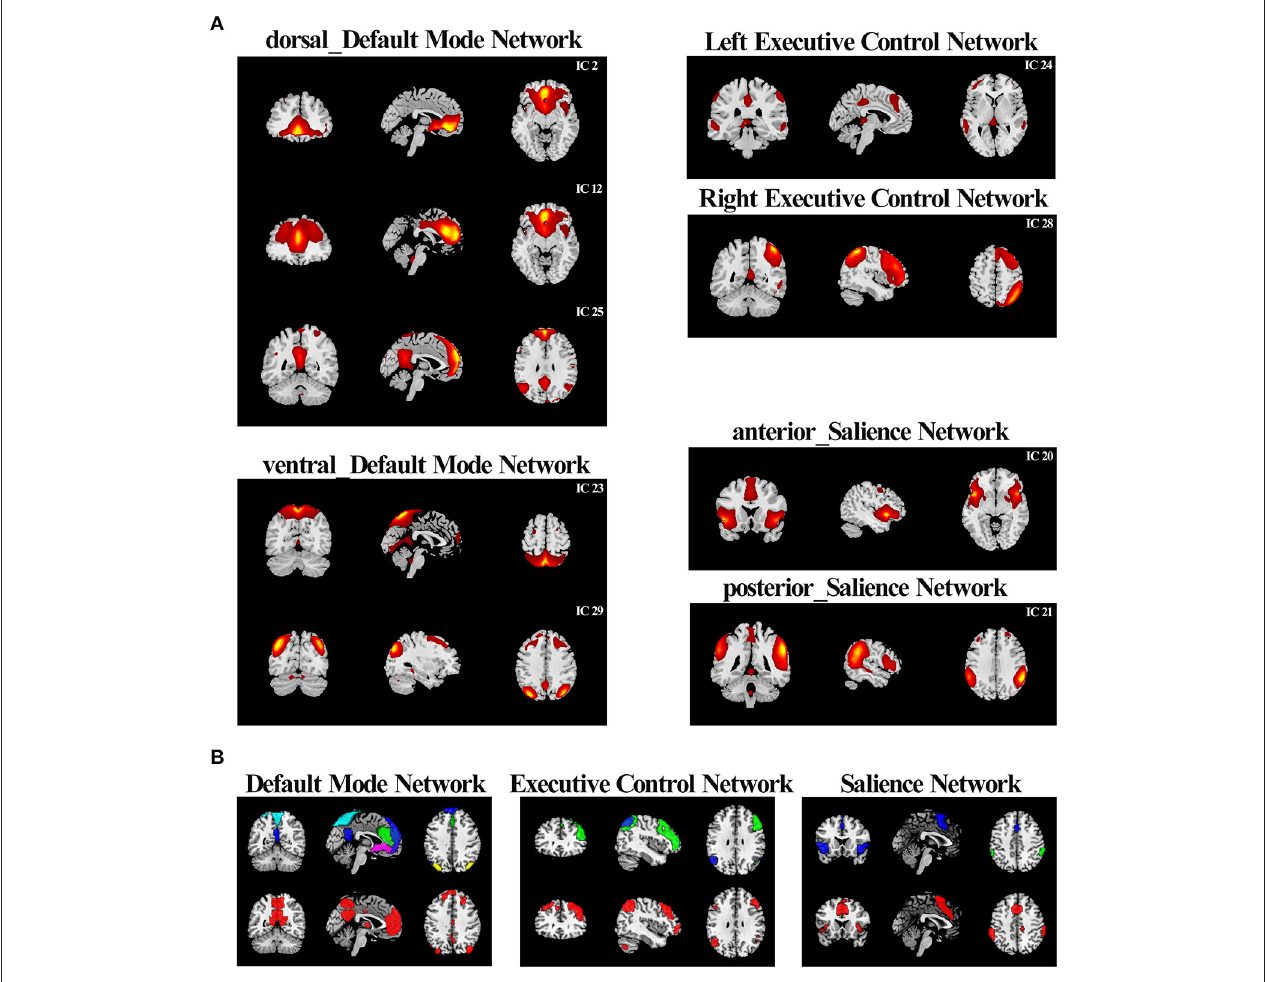
FIGURE 1 | Comparison between the “triple network” of this study and the template networks (A) According to the correlation with the triple-network model network templates, the resting-state networks of the current study were divided into six categories. (B) The comparison between resting-state networks in current research and the triple-network model templates. RSN combinations of the same category in the current study were drawn in contrasting colors and displayed on the top. The corresponding reference template was drawn in red and displayed on the